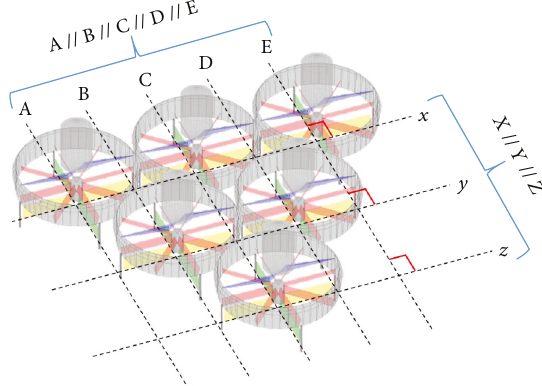
Figure 3: Arrangement of the control surfaces in the assembling